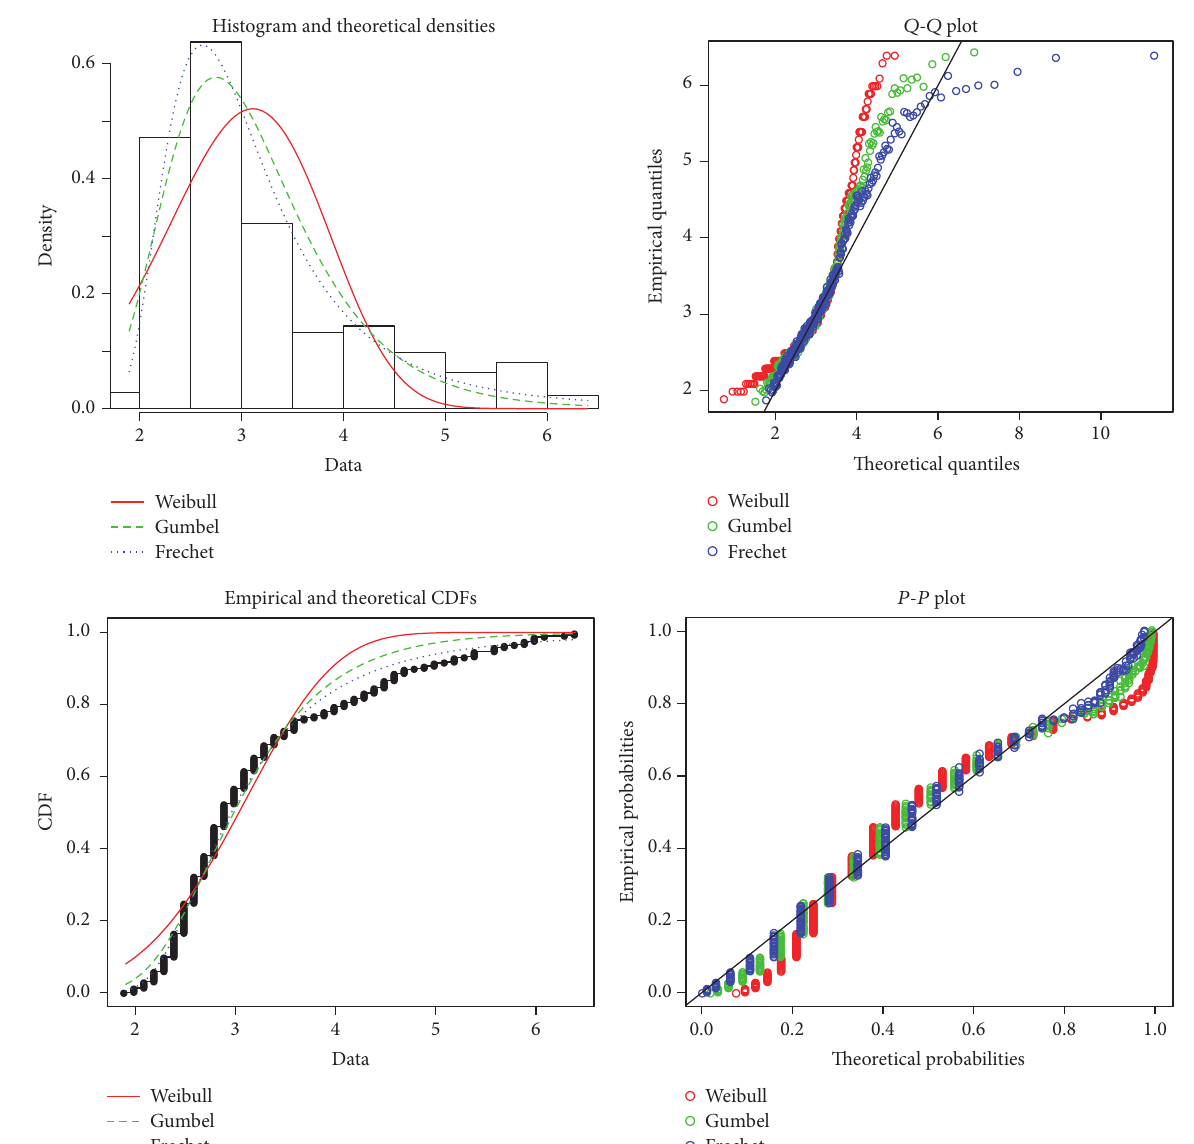
Figure 9: Monthly maximum wind speeds fitted to the GEV class of